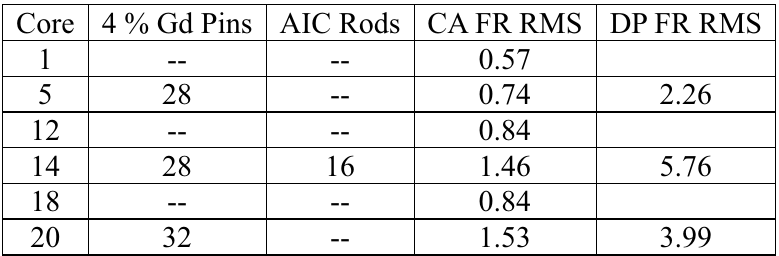
Table II. CASMO5 B&W 1810 critical experiments : FR results for Central Assembly (CA) and